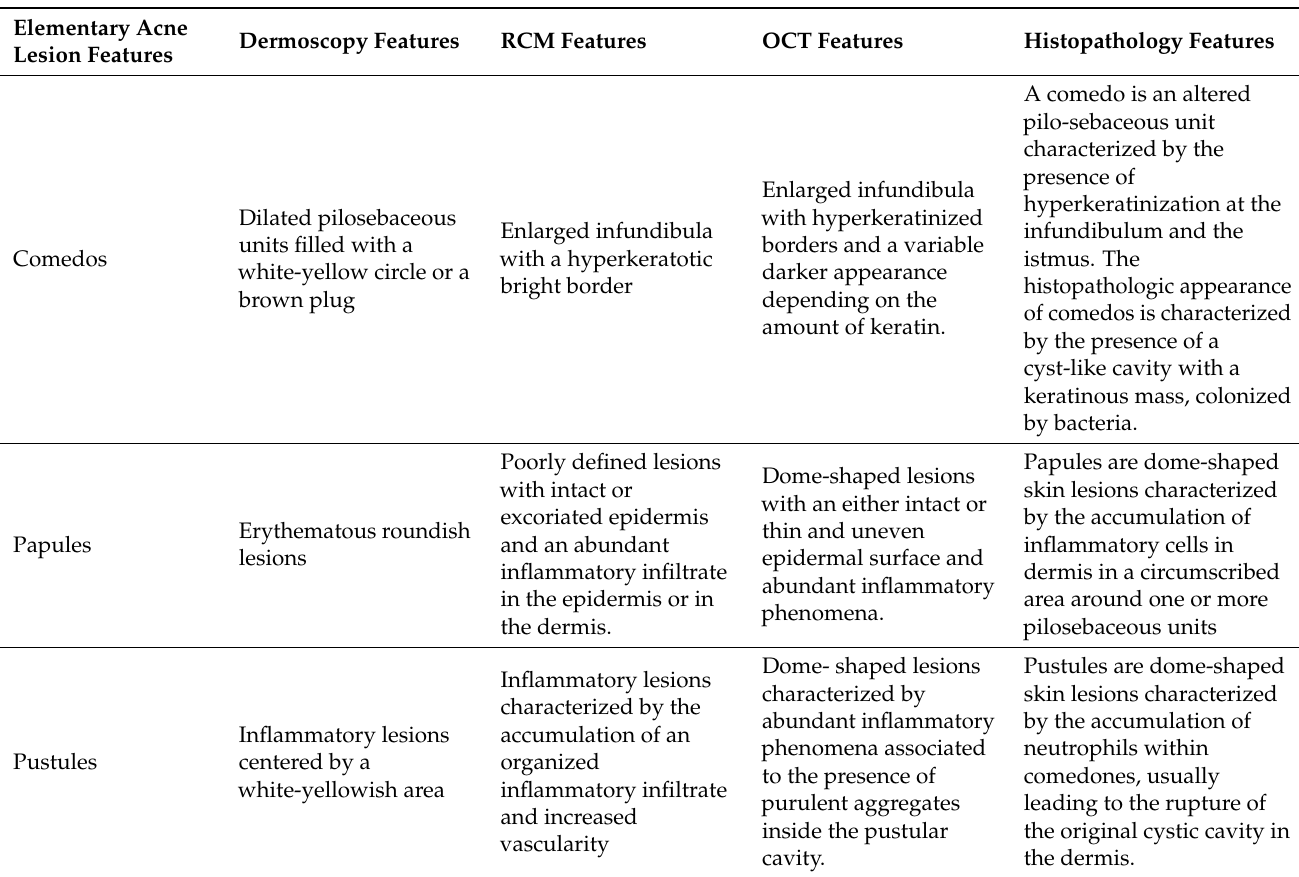
Table 1. Main dermoscopy, reflectance confocal microscopy, and optical coherence tomography and their histopathologic correlation in acne elementary